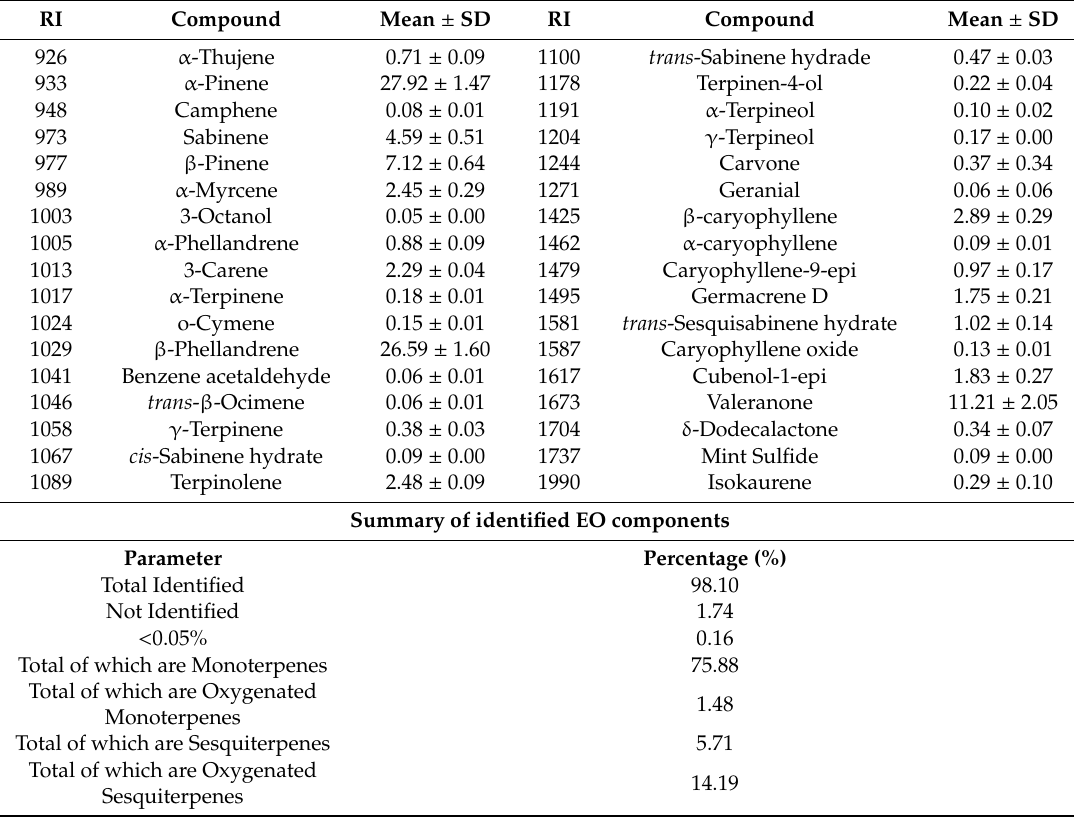
Table 3. Composition (%) of essential oils of S. perfoliata aerial parts, after GC / MS analysis and compound identification. Values are mean percentage (%) of three replicates ±